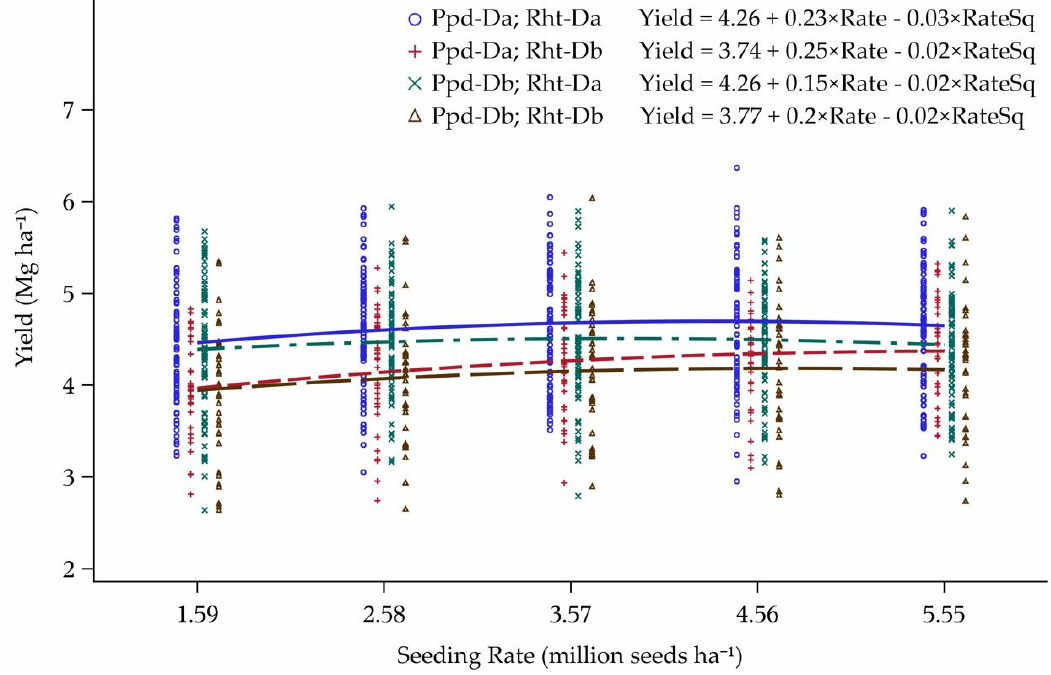
Figure 14. Yield response curves to seeding rate for the interaction between Rht-D and Ppd-D alleles over the six lowest-yielding environments in Minnesota and North Dakota, 2013–2015. Seeding rate for the peak of the curve: Ppd-Da ; Rht-Da = 3.83, Ppd-Da ; Rht-Db = 5.16, Ppd-Db ; Rht-Da = 3.36, and Ppd-Db ; Rht-Db = 4.15 million seeds ha − 1 .